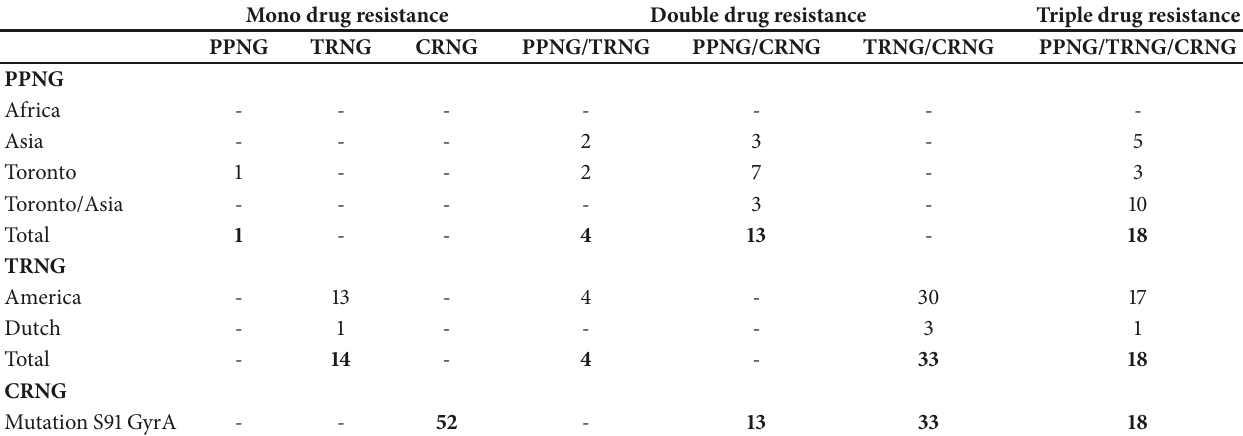
Table 3: Genotypic characterization of 145 NG positive samples.